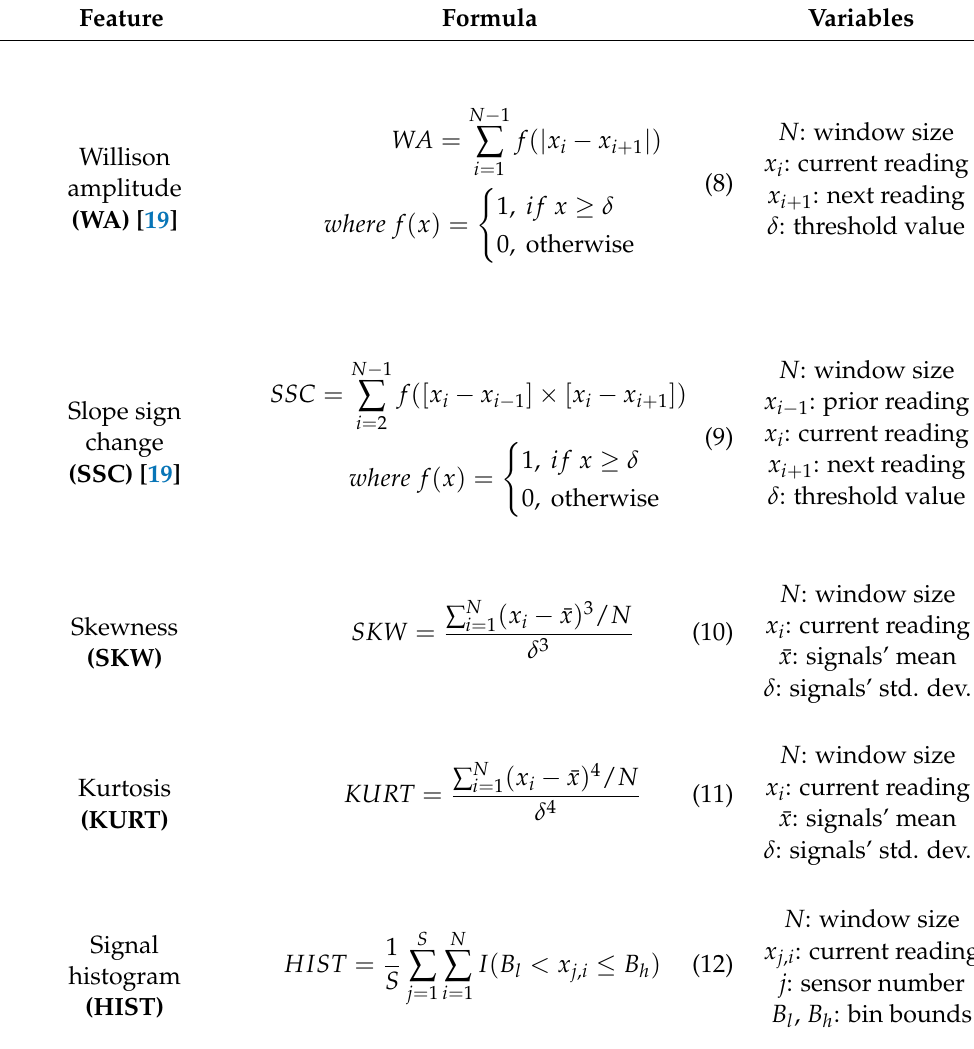
Table 1. Cont. Feature Formula